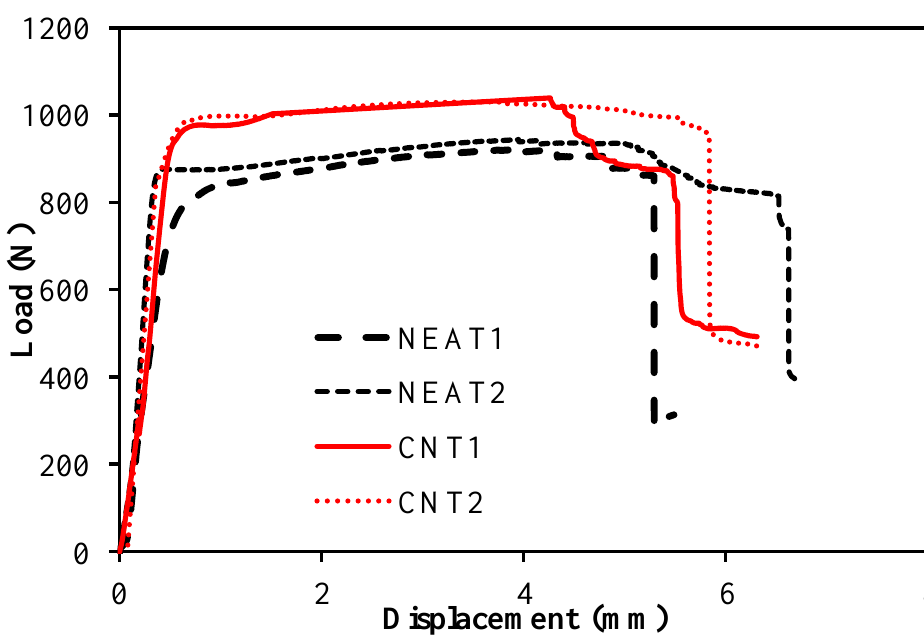
Figure 8. Buckling test results of the samples with simple – simple.